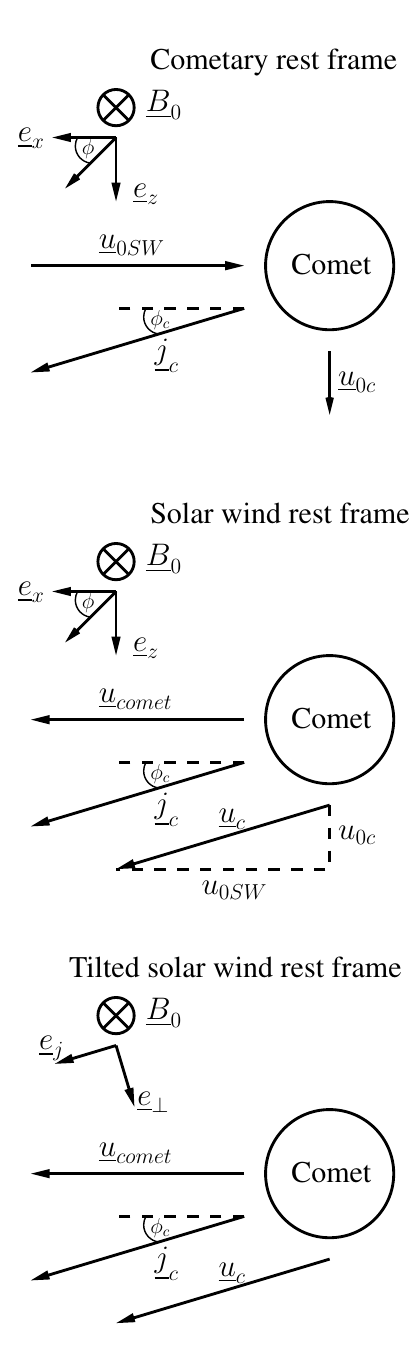
Figure 1. Illustration of the cometary rest frame CSEQ (top), so- lar wind rest frame SW (mid) and tilted solar wind rest frame TSW (bottom). Characteristic velocities of the solar wind u 0SW = − u = u = − u + u 0SW e x , cometary ions u c 0 0c e z and u c 0SW e x 0c e z and the comet u comet = − u 0SW are shown in the different frames. Additionally, the ambient magnetic field B 0 = B 0 e y , the cometary = n current j 0c u c , the definition of the azimuthal angle φ and the c characteristic angle φ c = arctan (u 0c /u 0SW ) between SW and TSW are